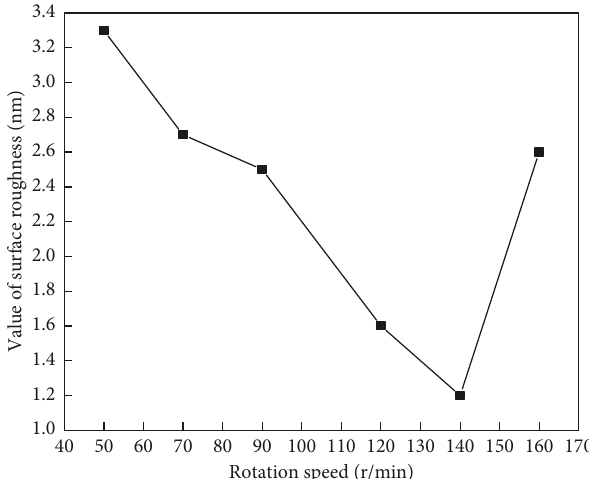
Figure 5: The relationship between the surface roughness and the rotation